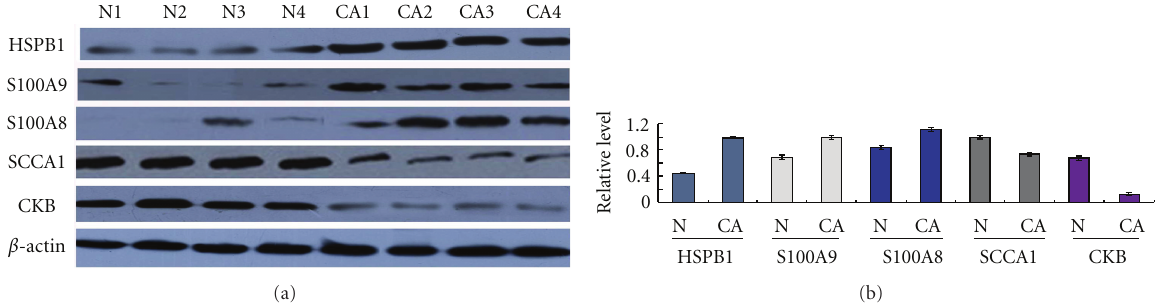
Figure 3: Representative results of Western blotting analysis of HSPB1, CKB, S100A8/A9, and SCCA1 in HLSC (CA) and NHBE (N). β -actin was used as a loading control.